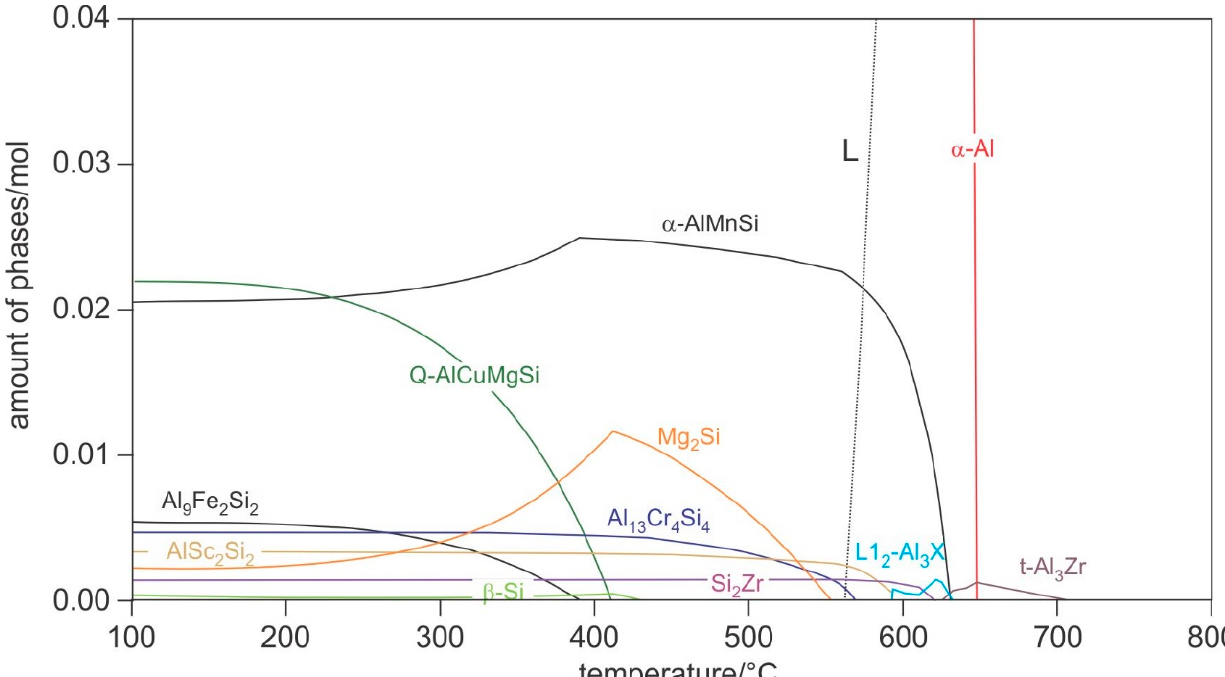
Figure 2. The amounts of phases as a function of temperature for the alloy 6086-0.2Sc, calculated by Thermo-Calc Software.